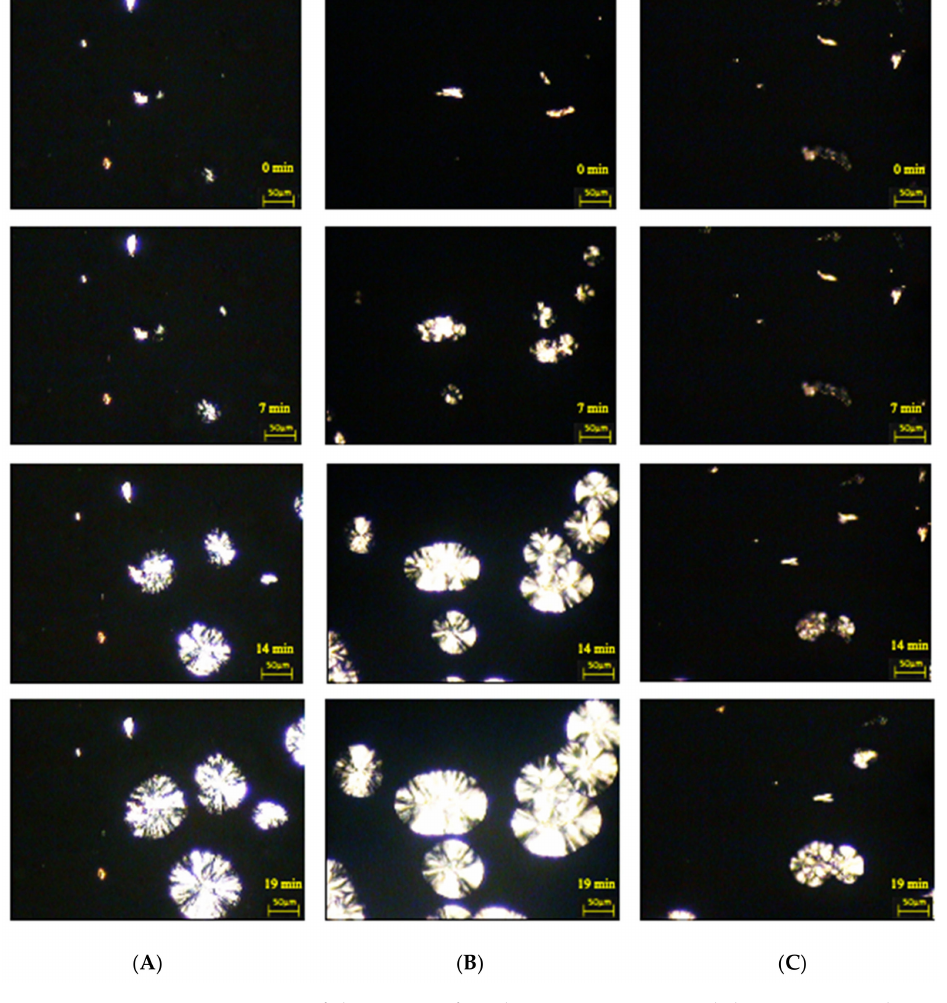
Figure 9. Microscopic images of the stages of nucleation processes and the increase in the crystal structure of isotactic polypropylene matrix (136 ◦ C) in the presence of cellulose fillers: ( A ) PP + Cel_A, ( B ) PP + Cel_A-Tr, ( C ) PP +